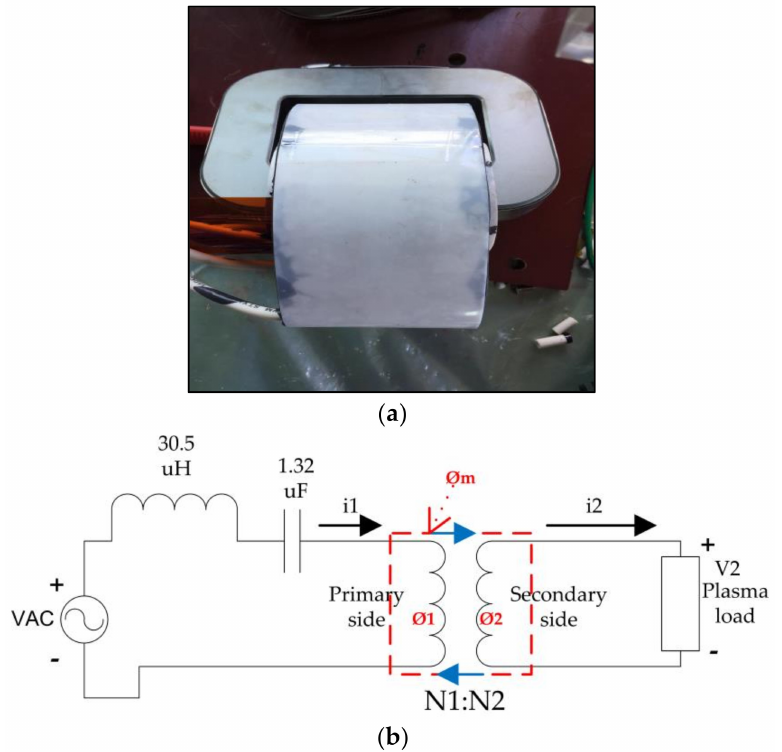
Figure 5. ( a ) High voltage high frequency transformer; ( b ) transformer equivalent